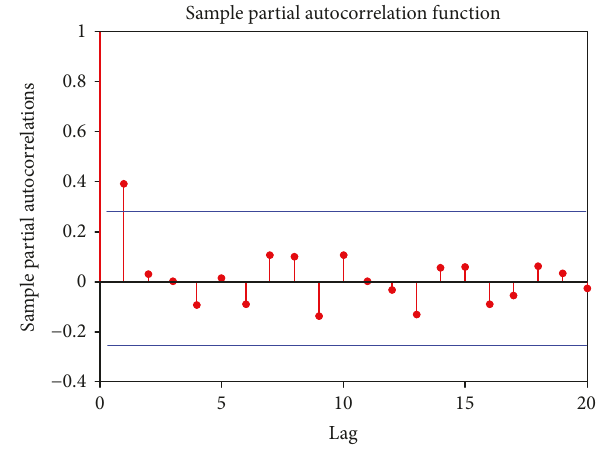
Figure 11: Error graph of the training of CNN.